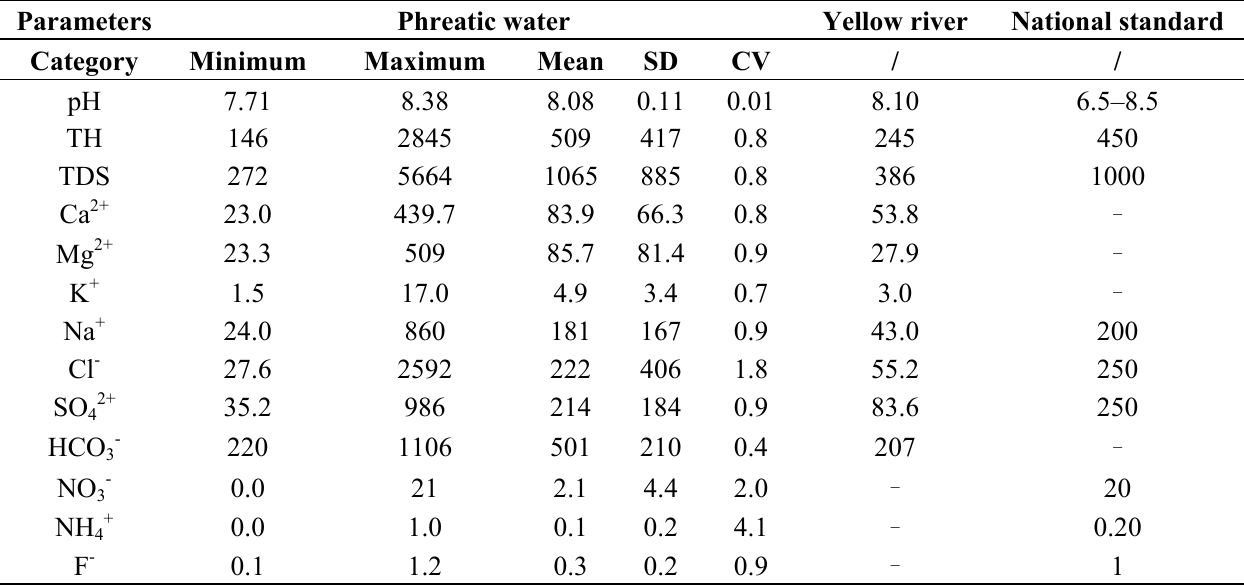
Note: Units: mg/L (except for